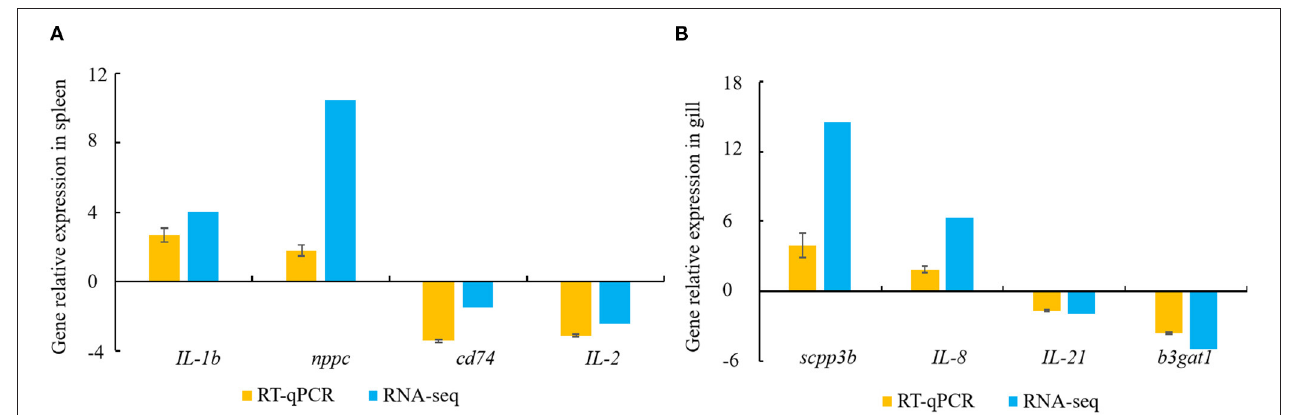
FIGURE 6 | DEGs validated by RT-qPCR. (A) spleen; (B) gill. Gene expression analysis from RNA-sequencing results and RT-qPCR validation results ( n =